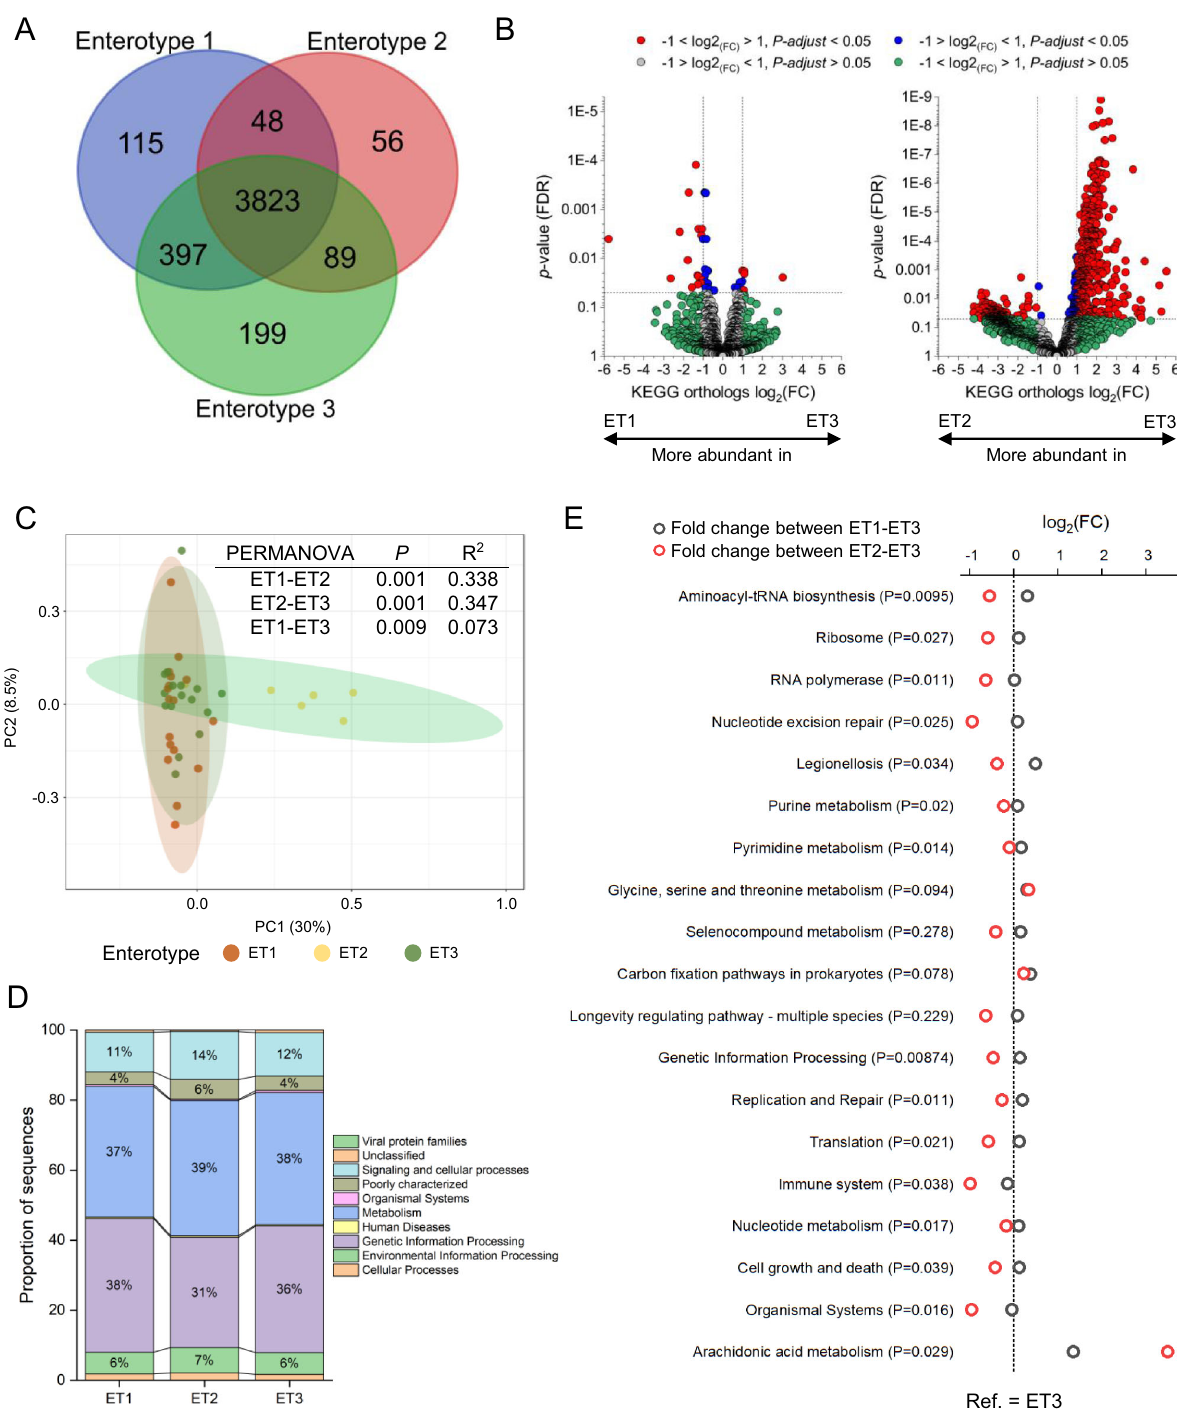
Fig. 6 Comparison of metabolic potential between enterotypes. A Venn diagram showing qualitative overlap of KEGG orthology terms (KO) between treatment-relevant enterotypes. B Volcano plots highlight quantitative differences (differences in normalized counts) at the KO level between enterotypes. The comparison was performed using Deseq2 and P -values were adjusted for multiple testing bias using the Benjamini – Hochberg procedure. C Principal component analysis to display community-level differences of KO. A PERMANOVA analysis was conducted to quantify these differences. D Bar chart showing the average relative abundances of high-level KEGG pathways, by enterotype. For clarity, only proportions of sequences above 2% are shown. E Comparison between enterotypes of relative abundances of metabolic pathways associated with positive soil-transmitted helminth infection status in previous studies 22 – 24 . A Kruskal – Wallis test was used in combination with the Benjamini – Hochberg multiple testing bias corrections to identify differences and fold changes were calculated to show the corresponding effect sizes. ET1 – 3 enterotypes 1 – 3, FC fold change, Ref.